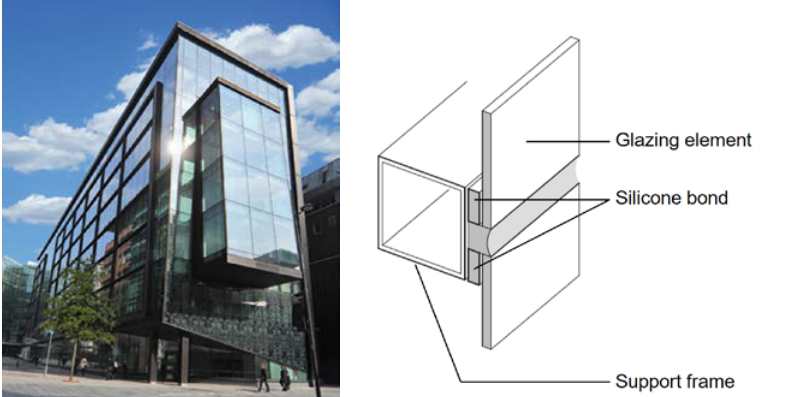
Fig. 2 St. Paul’s Square, Liverpool (left, Middleton-Pugh 2017), schematic illustration of a SSG system (right, Hestermann